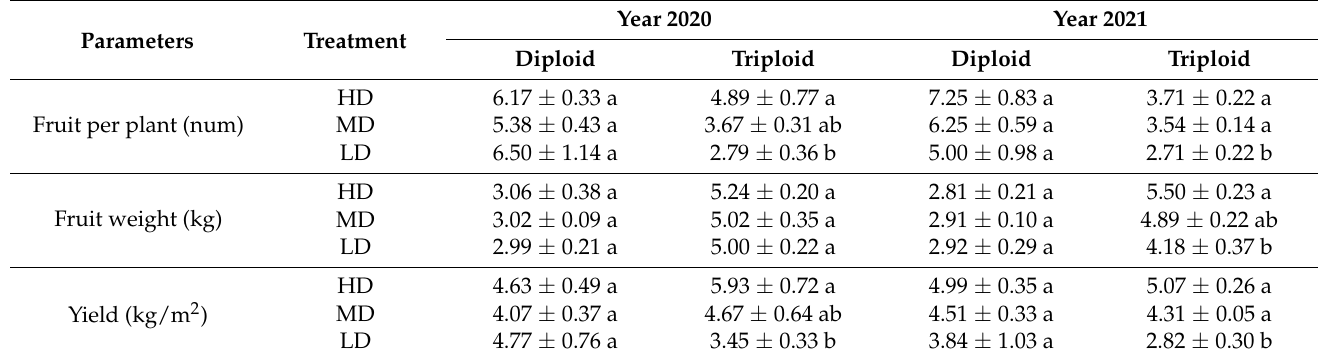
Table 4. Number of fruits per plant, fruit weight, and yield in the enclosures, for both watermelon cultivars. Years 2020 and 2021 for the three treatments (release density: HD, MD and LD).